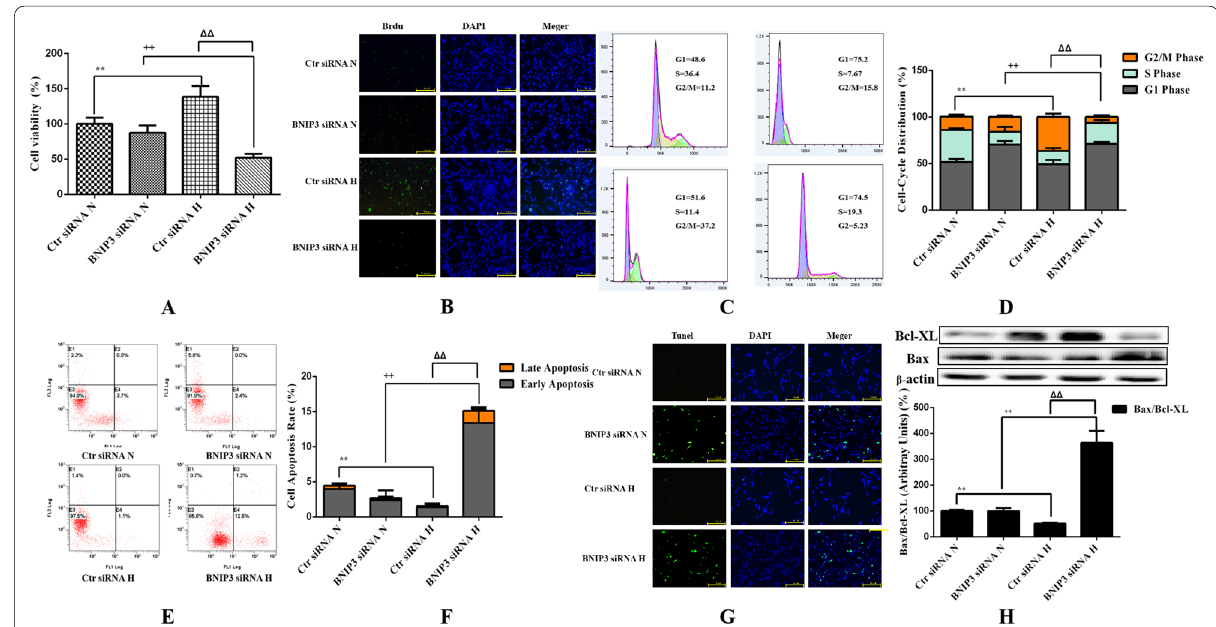
Fig. 5 Effects of low expression of BNIP3 on proliferation and apoptosis of RA-FLSs. A The effects of low expression of BNIP3 on the viability of RA-FLSs were detected by CCK-8 method (mean SD, n 6 from three independent experiments); B BrdU was incorporated into RA-FLSs, cells ± = were exposed to 21% and 2% O 2 for 24 h, and then BrdU (green) and DAPI (blue) immunostaining were detected; C Flowcytometry analysized the cell proliferation with PI staining after cells were treated with different oxygen concentrations for 24 h; D Histogram depicts quantitative data from the flow cytometric analysis (mean SD, n 5 from three independent experiments); E RA-FLSs were analyzed by FCM using Annexin V/PI ± = double-staining; F Histogram depicts the quantitative data from the AV/PI double-staining (mean SD, n 6 from three independent experiments); ± = G Representative fluorescence images of cells stained with TUNEL and Propidium Iodide to visualize apoptosis cells (Green) and nucleus (Blue); H The expressions of Bax and Bcl-XL was analyzed by Western blot (mean SD, n 6 from three independent experiments). # P < 0.05, ## P < 0.01 ± = represents the comparison between Ctr siRNA N and BNIP3 siRNA N; *P < 0.05, **P < 0.01 represents the comparison between Ctr siRNA N and Ctr siRNA H, + P < 0.05, ++ P < 0.01 represents the comparison between BNIP3 siRNA N and BNIP3 siRNA H, Δ P < 0.05, ΔΔ P < 0.01 represents